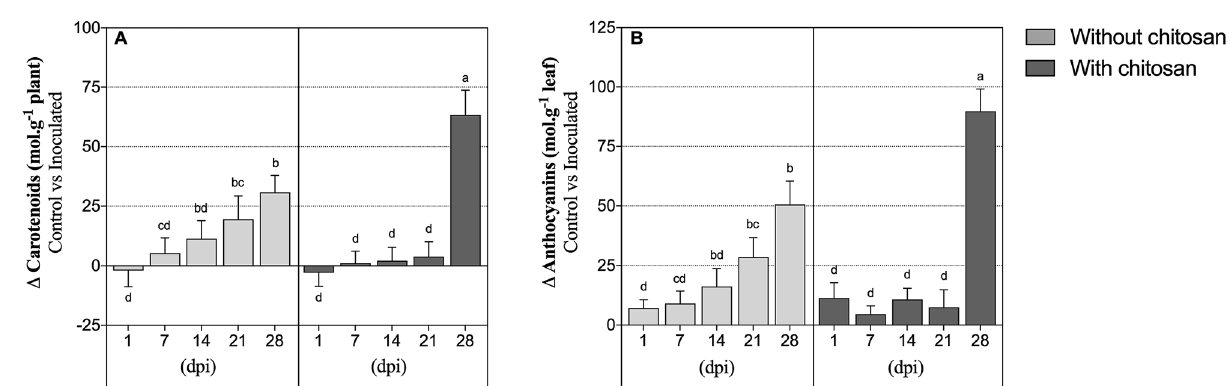
Figure 2. Lipid peroxidation and antioxidant activity. Malondialdehyde concentration and catalase activity in P. pinaster leaf tissues 1, 7, 14, 21 and 28 days post-inoculation (dpi) with the pinewood nematode (PWN) B. xylophilus . Plants were inoculated 14 days following the application of 0.5% acetic acid (without chitosan, non- elicited controls) or a chitosan solution to plants’ substrate. Data represents the difference between the averages of PWN-inoculated and water-inoculated plants ± SE, and different letters indicate statistically different means at P < 0.05.